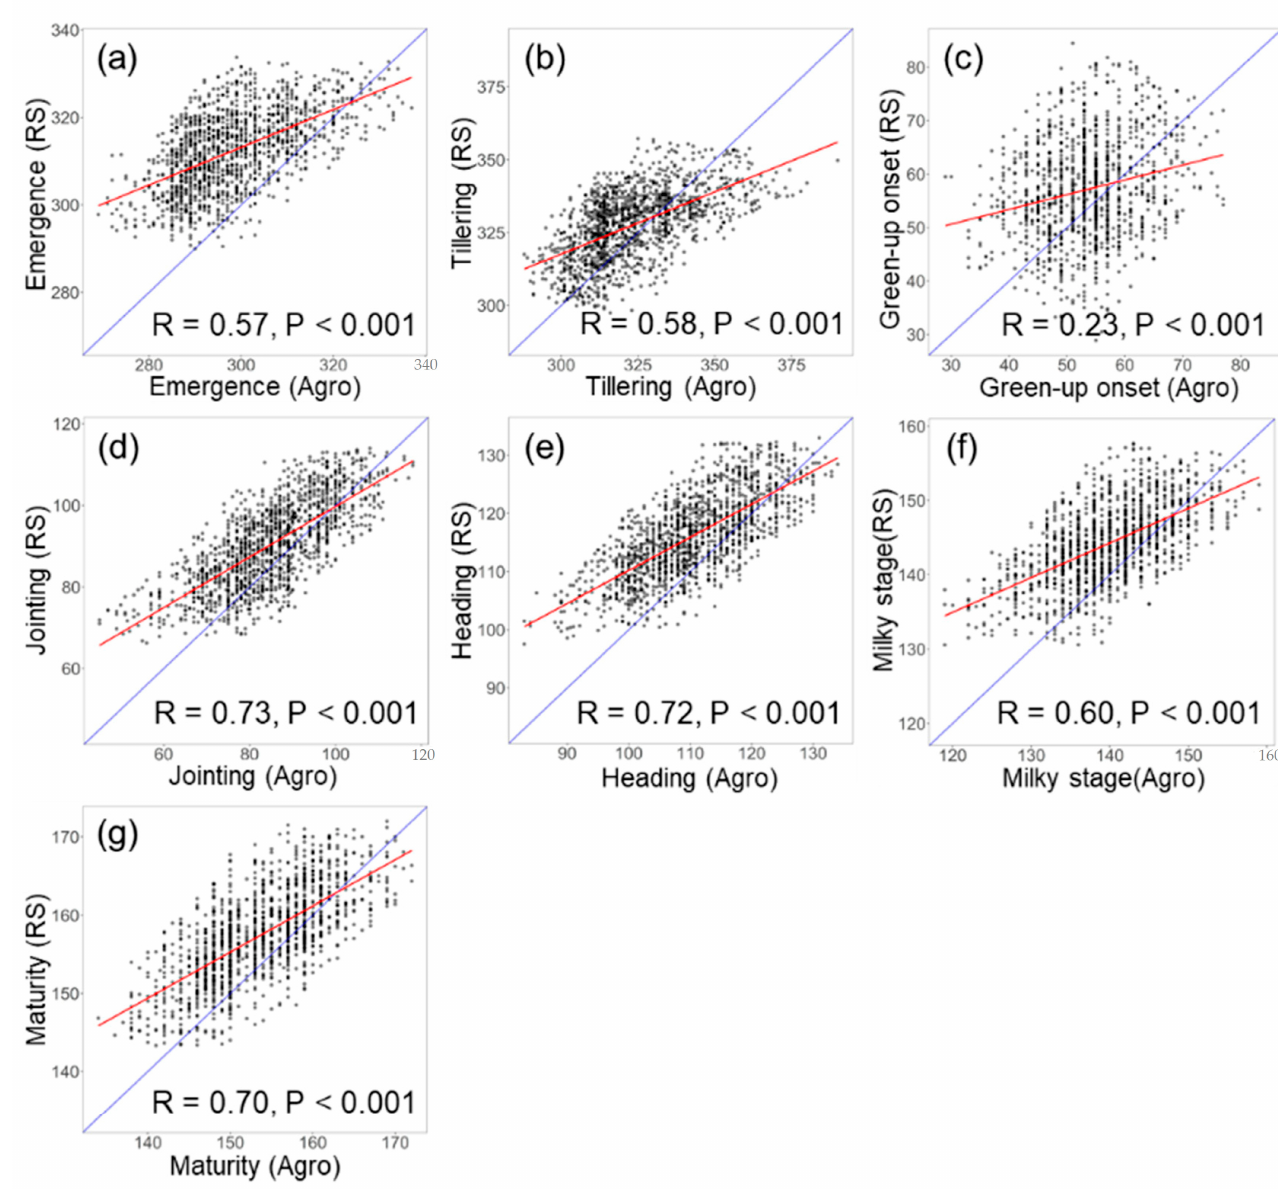
Figure 4. Comparison between CRTM-extracted phenological dates (Y-axis) and ground-based phenological observations (X-axis). ( a ) represents scatter plot for emergence, ( b ) represents scatter plot for tillering, ( c ) represents scatter plot for green-up onset, ( d ) represents scatter plot for jointing, ( e ) represents scatter plot for heading, ( f ) represents scatter plot for milky stage, and ( g ) represents scatter plot for maturity,